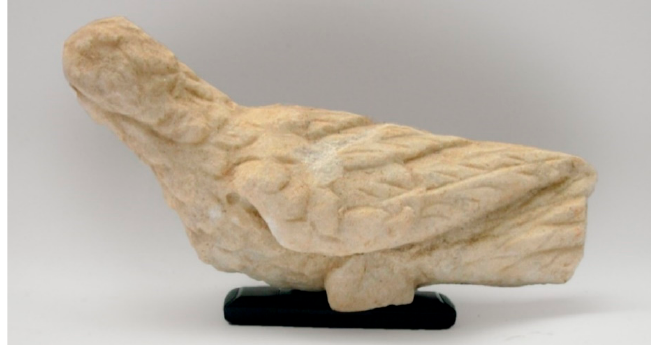
Figure 11. Worn body of a bird (probably an eagle) with carefully rendered feathers (MGW inv. no. 2776); marble sculpture; Roman period. no. 2776); marble sculpture; Roman